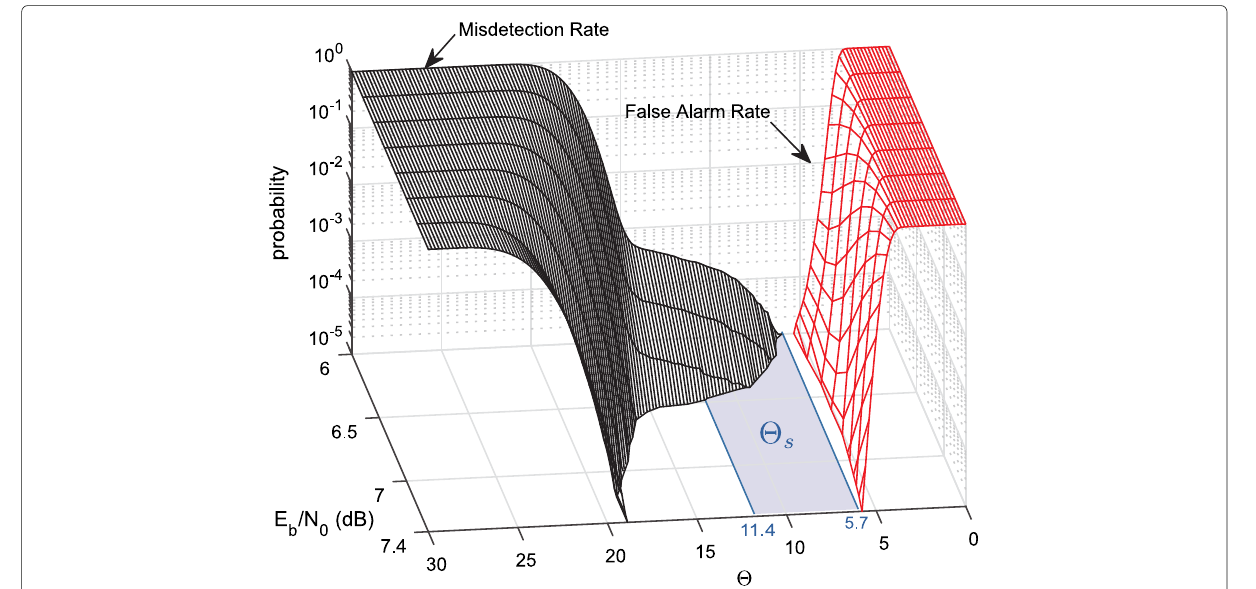
Fig. 4 False alarm rate and misdetection rate vs. E b / N 0 vs. threshold